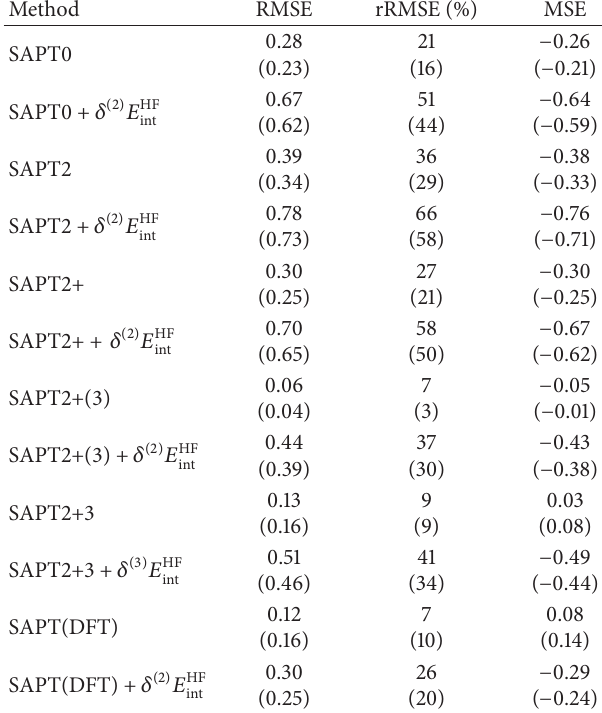
Table 2: Errors (RMSE, rRMSE (%), and MSE; in kcal/mol or %) in 𝐸 int obtained from various SAPT methods. The errors without parentheses have been calculated relative to the CCSD(T)/def2- QZVPP+mb results, while those put in parentheses are based on the CCSD(T)/CBS reference values of 𝐸 int